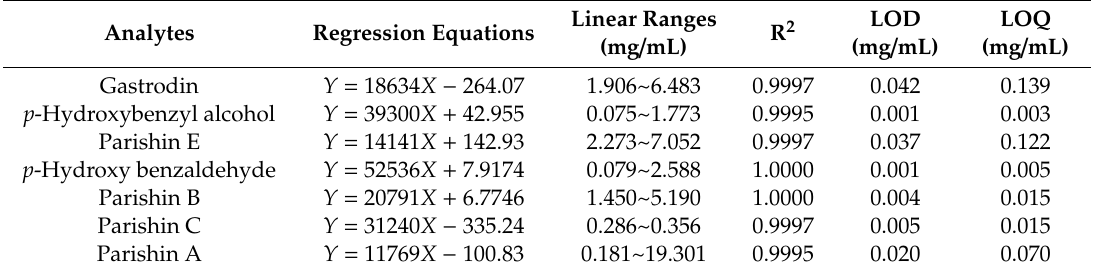
Table 1. The regression equations, Limit of Detection (LODs) and Limit of Quantity (LOQs) of seven components.